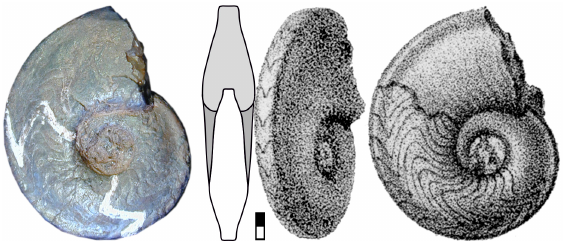
Fig. 19. Acanthoclymenia forcipifera (Sandberger & Sandberger, 1851); lectotype 36a in the